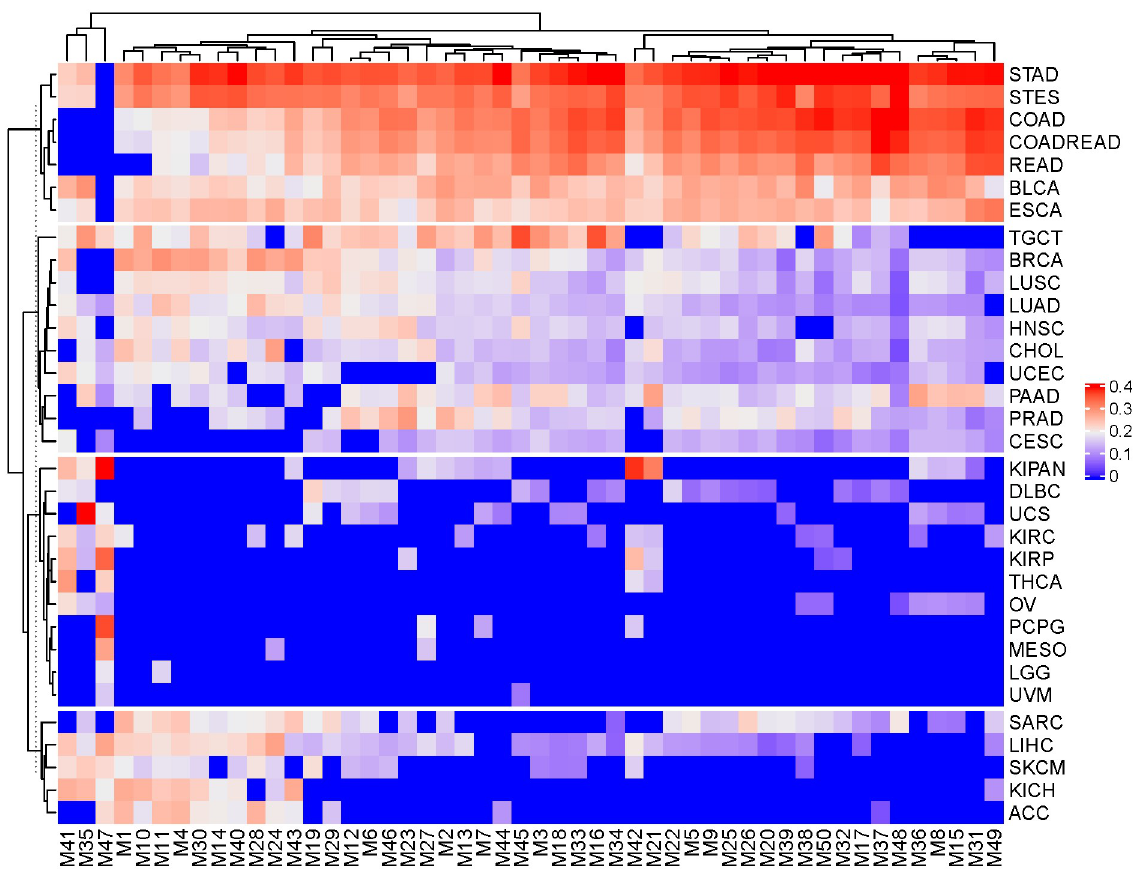
Fig 4. Heatmap showing W , which is the output matrix of Algorithm 2 (See S1 Text), when it was applied to the TCGA data. Each column corresponds to a module and each row corresponds to a cancer type and | W ij | reflects the co-expressed intensity of between the genes and the miRNAs within the module j on the cancer i . A hierarchical clustering method was used to cluster the rows (cancer types) into four clusters.